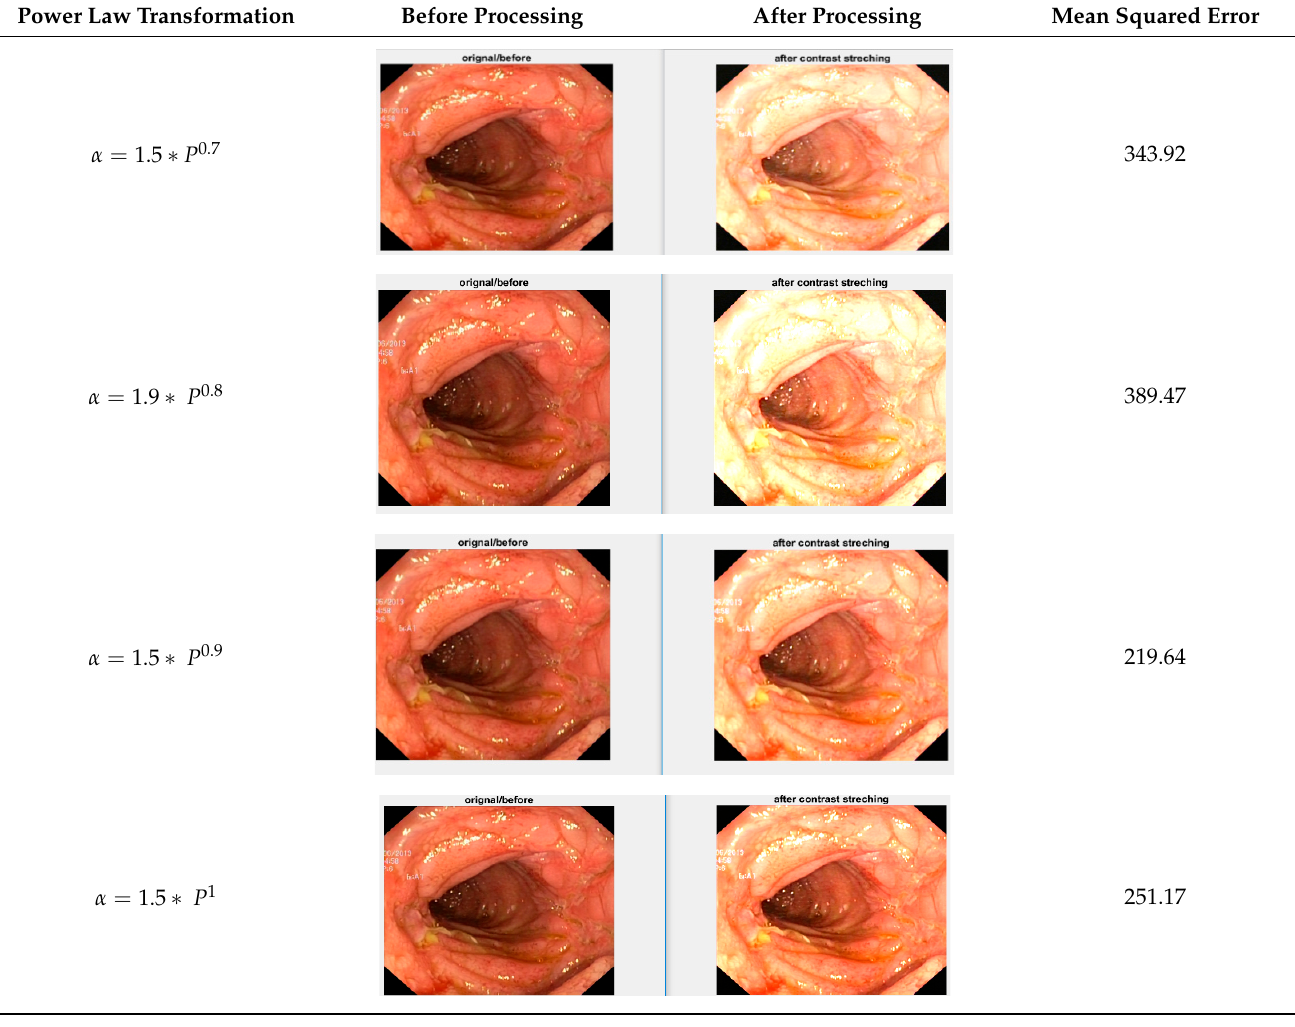
Table 1. Results after applying power law transformation.